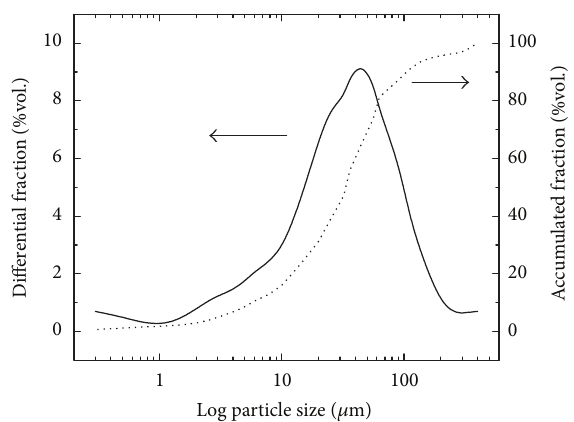
Figure 2: Particle size distribution and accumulated fraction of coal fly ash.